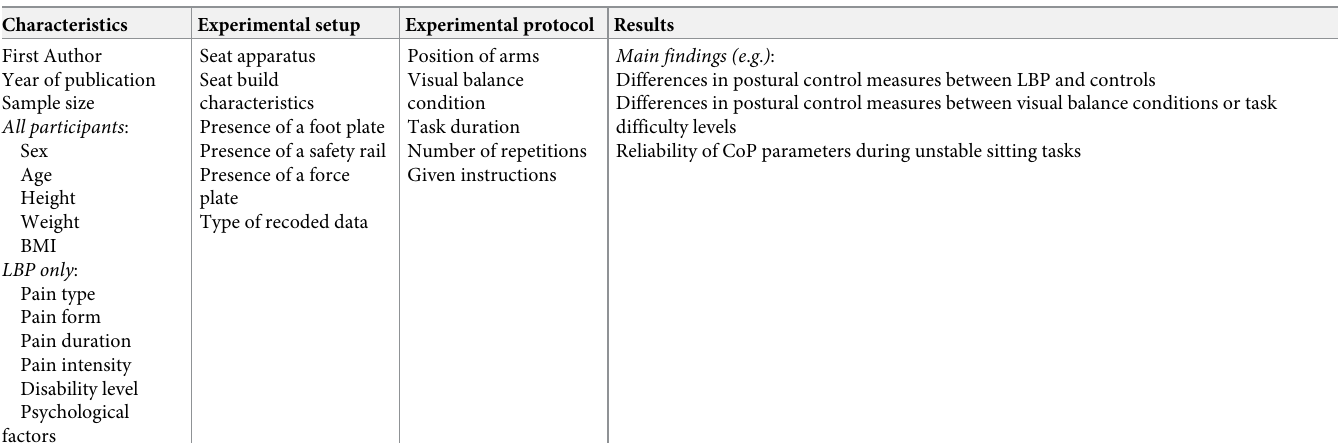
Table 4. List of data for the descriptive analysis.